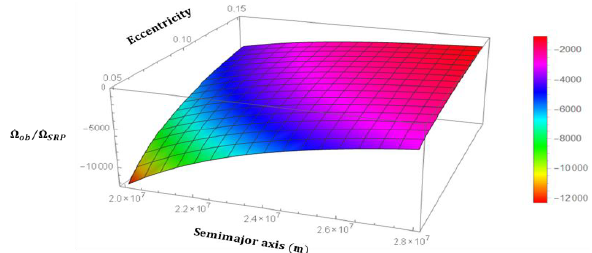
Figure 2. ˙ Ω ob / ˙ Ω SRP vs. semimajor axis and eccentricity